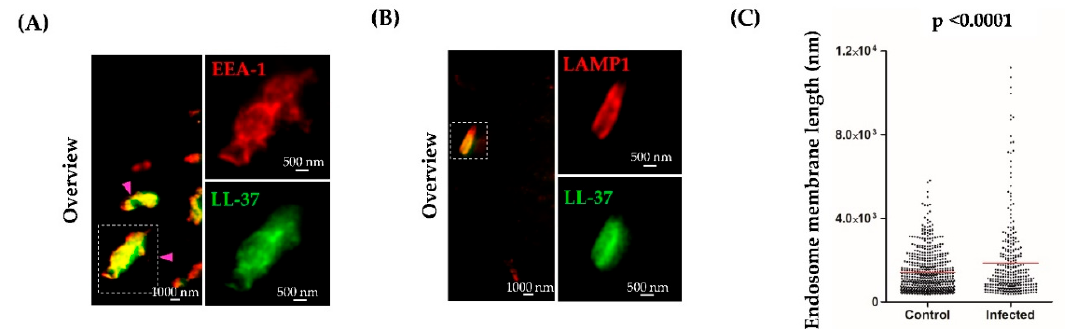
Figure 4. LL-37 colocalizes with early endosomes and phagolysosomes in infected macrophages. Macrophages were infected with Mtb (multiplicity of infection; MOI = 50) and incubated with LL-37-TAMRA overnight. Early endosomes or phagolysosomes were labelled using an anti-EEA1 (early endosome antigen 1 protein) or anti-LAMP1 (lysosomal-associated membrane protein 1) antibody, respectively. LL-37-TAMRA is depicted in green and early endosomes or phagolysosomes in red. ( A , B ) Images show representative areas of three donors, with specific regions for EEA1 or LAMP1. ( C ) Graph shows the endosome membrane length in uninfected and infected macrophages after LL-37 incubation (n = 4). Statistical analysis was performed using a Students t-test for unpaired samples. Images were acquired using dual color STED microscopy. Scale bar is 1000 nm for overview images and 500 nm for the shown region of interest.